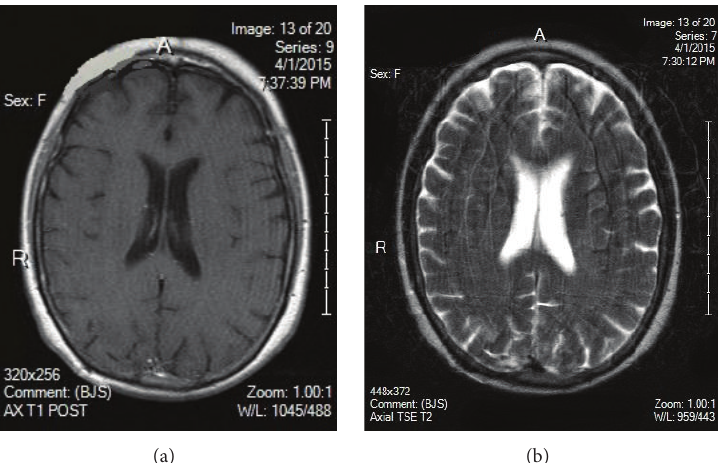
Figure 5: (a), (b) One-month follow-up: no abnormal enhancement; no mass or mass effect. Burr hole for the brain biopsy can be seen in the right posterior